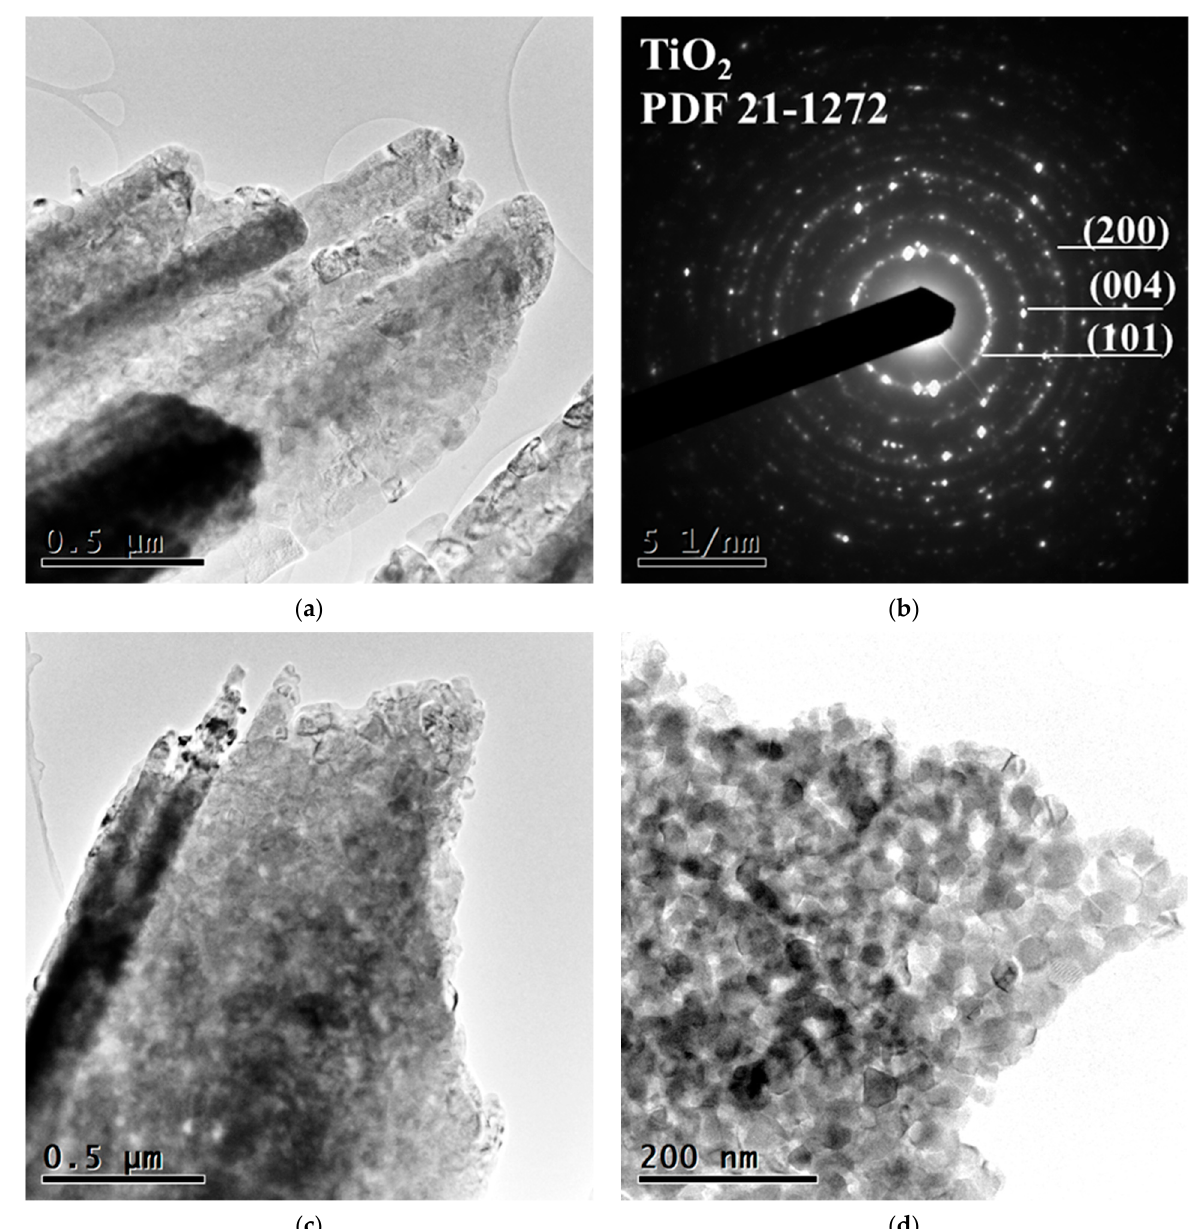
Figure 8. HRTEM analysis of sample Cu/TiO 2 _650, ( a ) Cu/TiO 2 _650 with a magnification of 0.5 μ m, ( b ) Cu/TiO 2 _650 SAED pattern, ( c ) Cu/TiO 2 _650 with a magnification of 0.5 μ m, ( d ) Cu/TiO 2 _650 with a magnification of 200 nm.